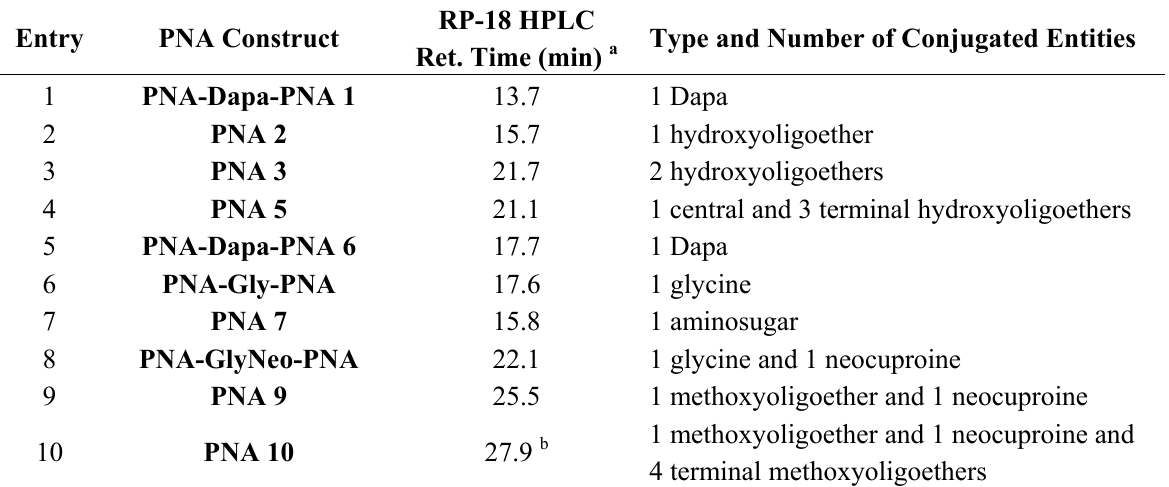
Table 1. RP-18 retention times for PNA